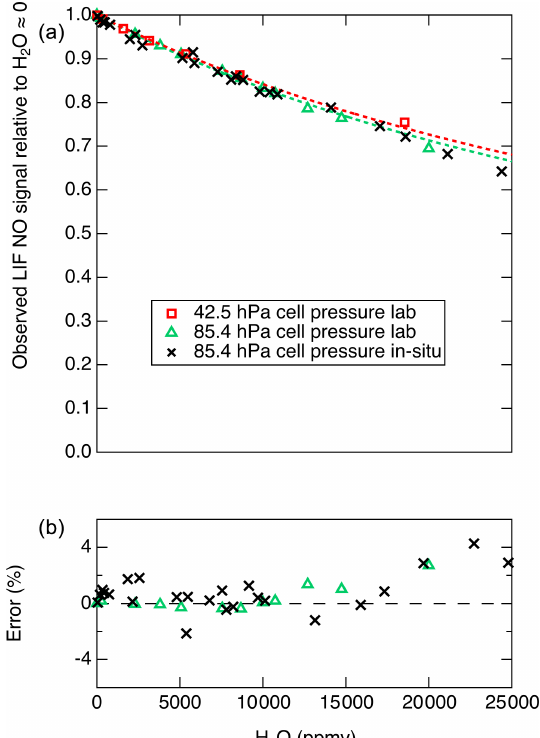
Figure 7. (a) Markers show the observed S/S 0 values, and dashed lines show the calculated S/S 0 values using k H 10 − 10 cm 3 molecules − 1 s − 1 . (b) Relative difference between ob- served and calculated S/S 0 values shown in (a)